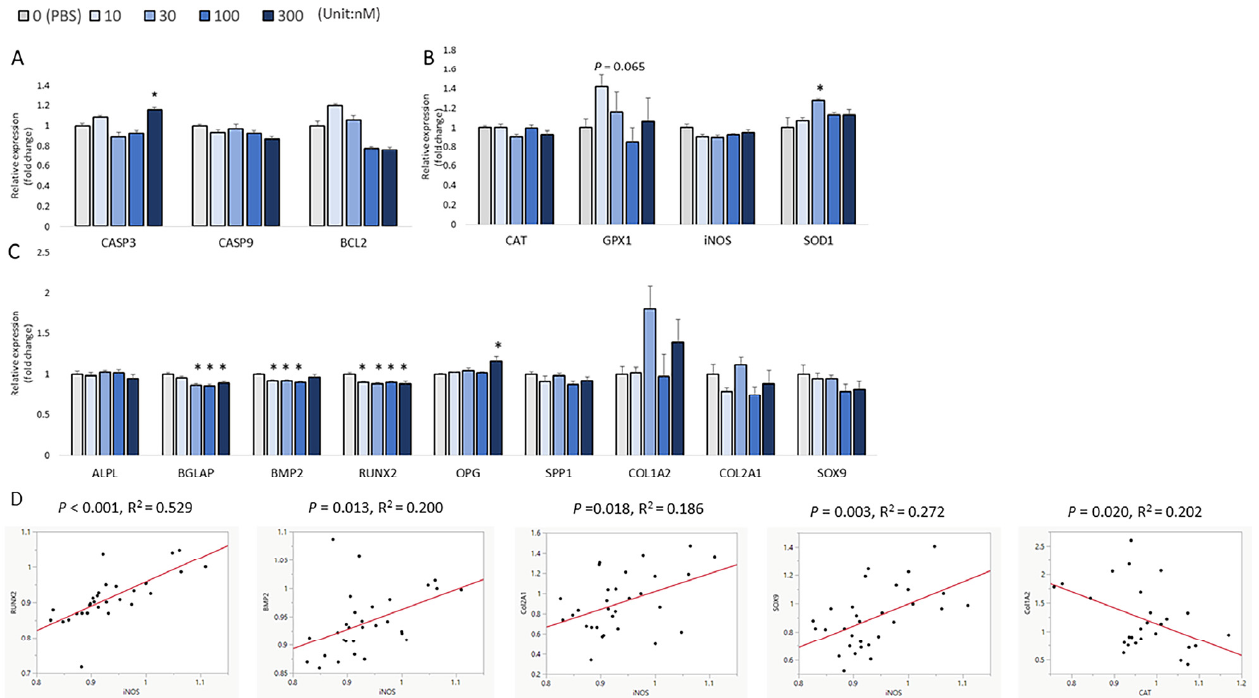
Figure 6. Effects of H 2 O 2 on the mRNA expression of three sets of genes in chicken embryos at 48 h post-injection. ( A ) Apoptotic genes’ expression; ( B ) Antioxidant enzymes’ gene expression; ( C ) Expression of bone formation biomarkers. Each value represents the mean ± SEM (N = 8). Treatments with * showed a significant difference compared with the control using the Dunnett’s test, p < 0.05. ( D ) The correlation between antioxidant enzyme-coding genes’ expression and bone formation genes’ expression was evaluated by using pairwise correlations (JMP Pro14).